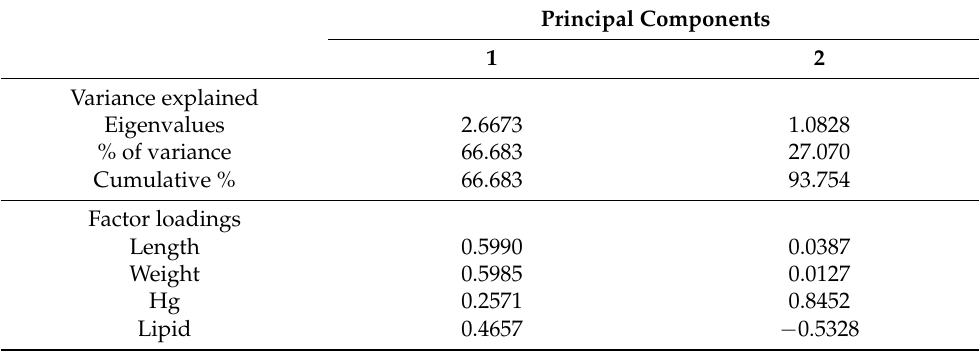
Table 2. Principal component analysis. Eigenvalues, explained and cumulative variance, loadings of the variables for the first two PCs.